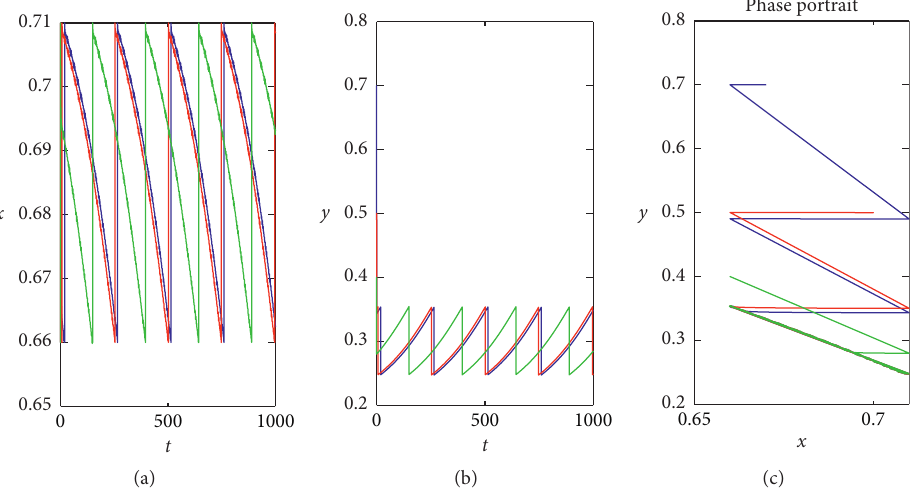
Figure 7: The order-1 periodic solution of system (11) with p � 0.3.